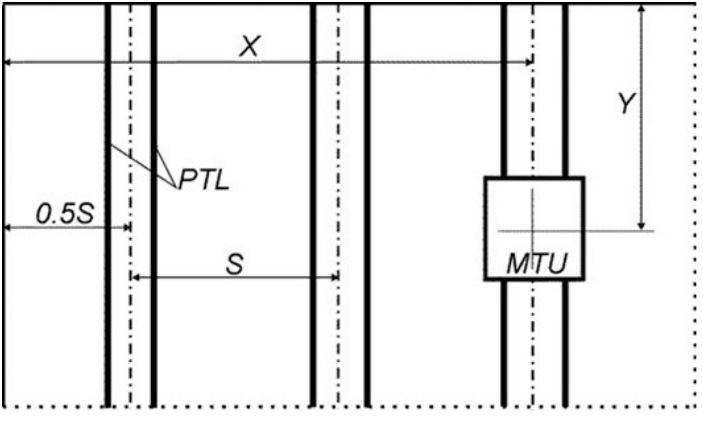
Figure 9. Diagram for determining MTU coordinates on a field with PTL.